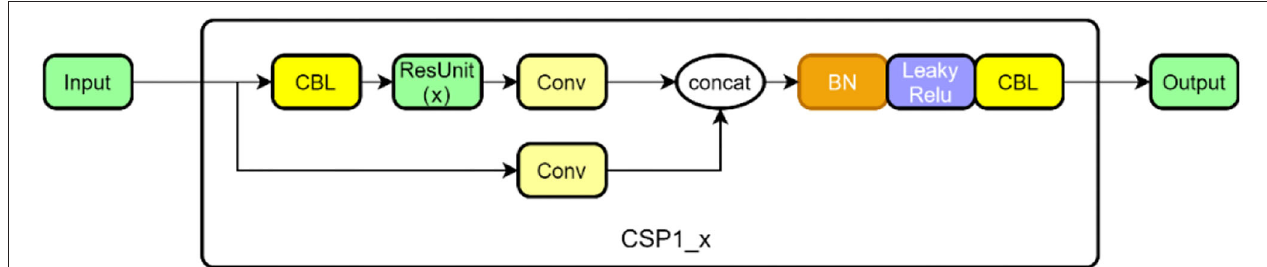
FIGURE 4 | CSP1 structure in backbone.